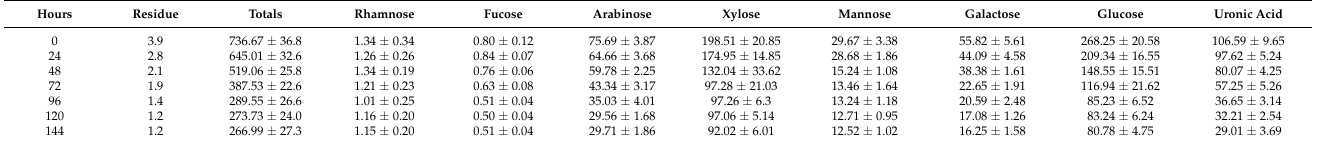
Table 3. Monosaccharide insoluble sugars compositions of waste cell walls during the fermentation process.